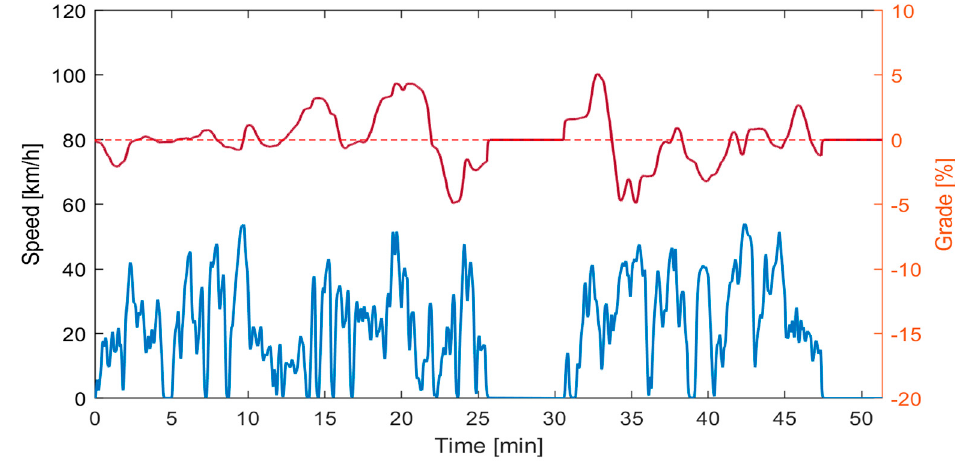
Energies 2020 , 13 , x FOR PEER REVIEW 8 of 16